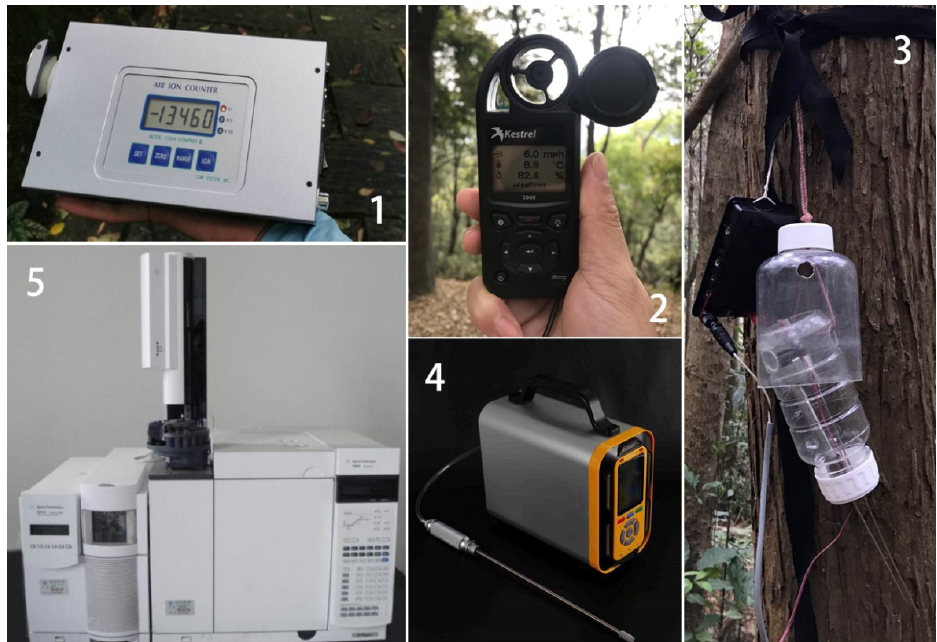
Figure 3. The experimental instruments. 1 — COM-3200PRO II negative ion monitor (Guangzhou Extreme Technology Co., Ltd., Guangzhou, China); 2 — Kestrel 5500 hand-held meteorological instrument (Beijing Kestrel Instrument & Meter Co. Ltd., Beijing, China); 3 — Gas collecting equipment; 4 — TD6000-SH-O2 oxygen content tester (Beijing Tiandi Shouhe Technology Development Co., Ltd., Beijing, China); 5 — Agilent 7890B-5977B/GC-MS.